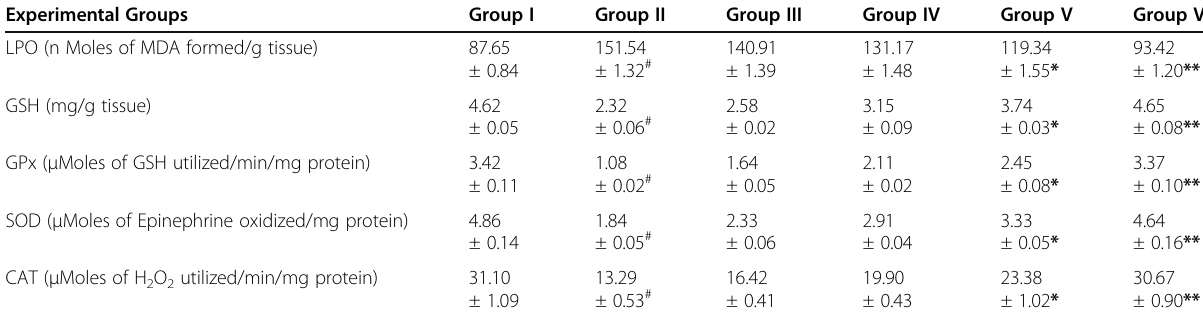
Table 5 Antioxidants Levels in Experimental Rats Experimental